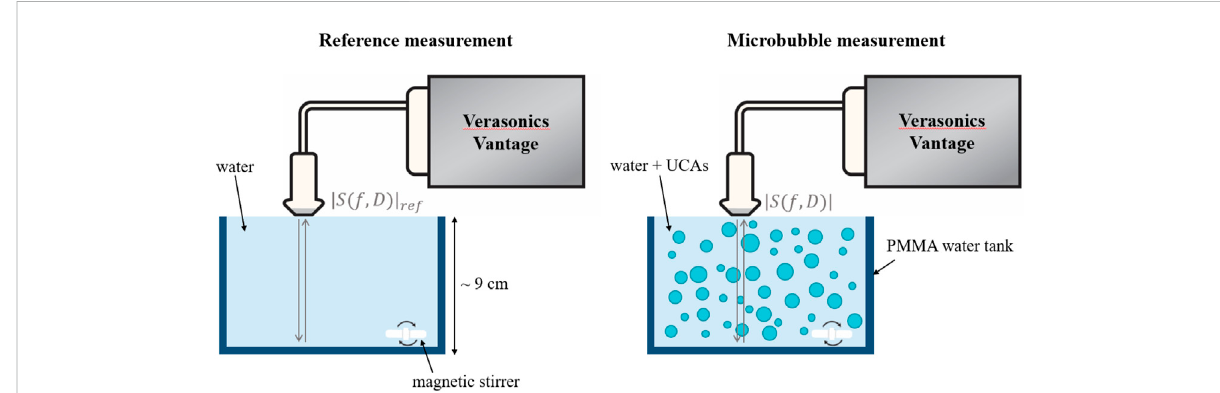
FIGURE 2 Experimentalsetupusedtoacquirethe invitro datawithSonoVuemicrobubbles.Thebackscatteredsignalsfromawaterphantomcontaininga dispersion of microbubbles were recorded using aP4-1 probe and Verasonics Vantage system. The attenuationcoef fi cient was obtained both using the reference phantom method and using the proposed LLS approach. For the reference phantom method, the signal backscattered from the bottomwallofthewatertankintheabsenceofmicrobubbleswasusedasareference(left)andcomparedtothesignalacquiredinthepresence of microbubbles (right). In contrast, the LLS approach only made use of the signal backscatted by the microbubble dispersion